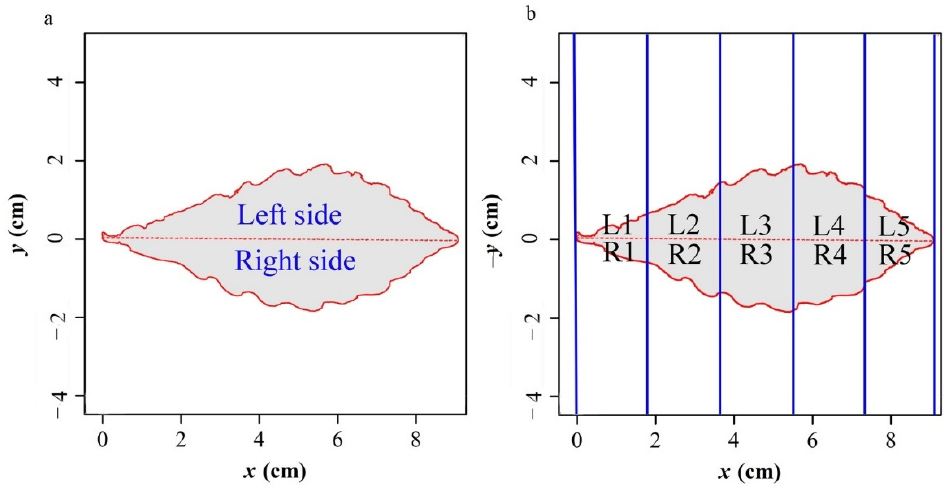
Figure 3. ( a ) Illustration of the areal ratio (AR) calculations of the left to right sides, and ( b ) the standardized index (SI) for measuring leaf bilateral symmetry.